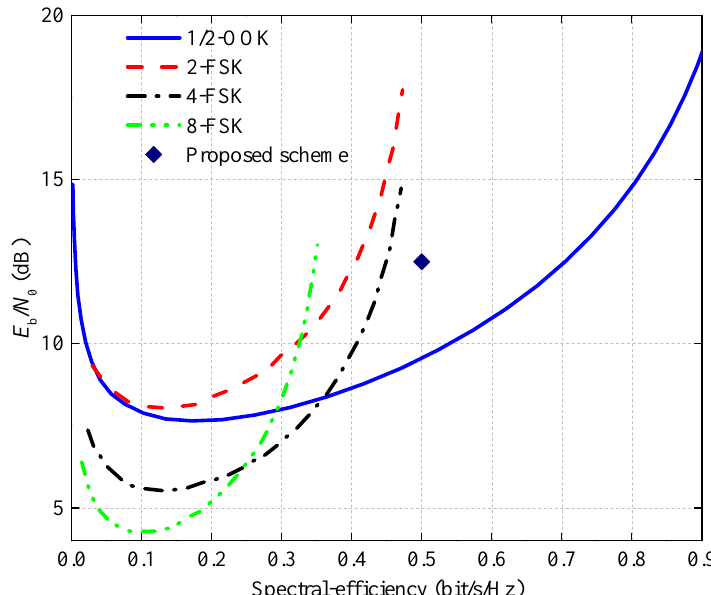
Figure 2. Capacity of four noncoherent modulations under flat Rayleigh fading channel without CSI on the receiver